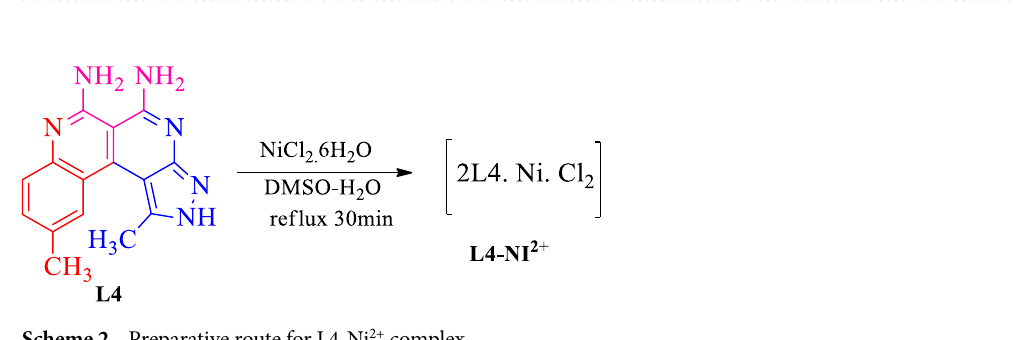
Scheme 2. Preparative route for L4-Ni 2+